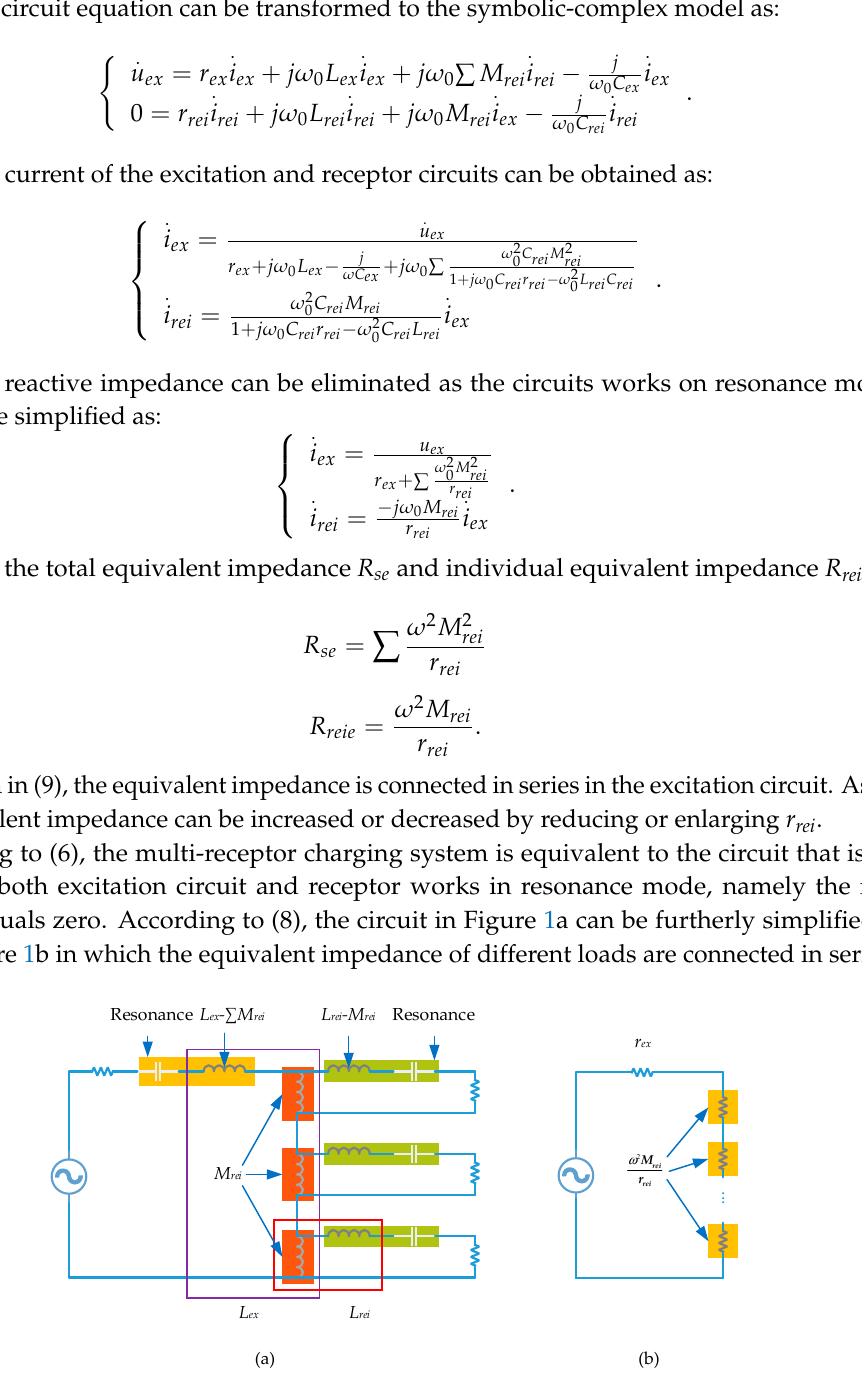
Figure 1. Equivalent circuit of multi-receptor charging system . ( a ) Inductance equivalent circuit; ( b ) Impedance equivalent circuit.